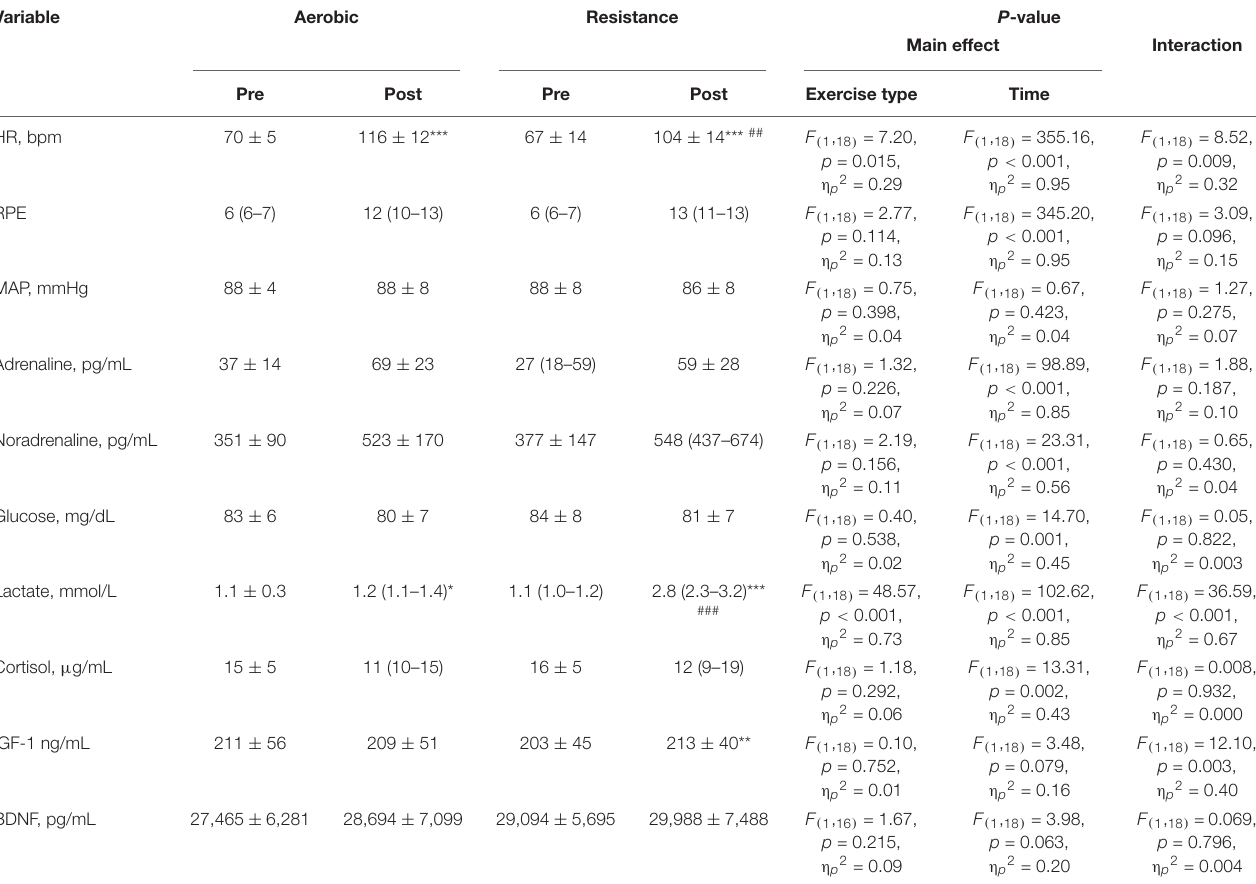
TABLE 1 | Heart rate (HR), MAP, and peripheral biomarkers before and after acute aerobic and resistance exercise. Variable Aerobic